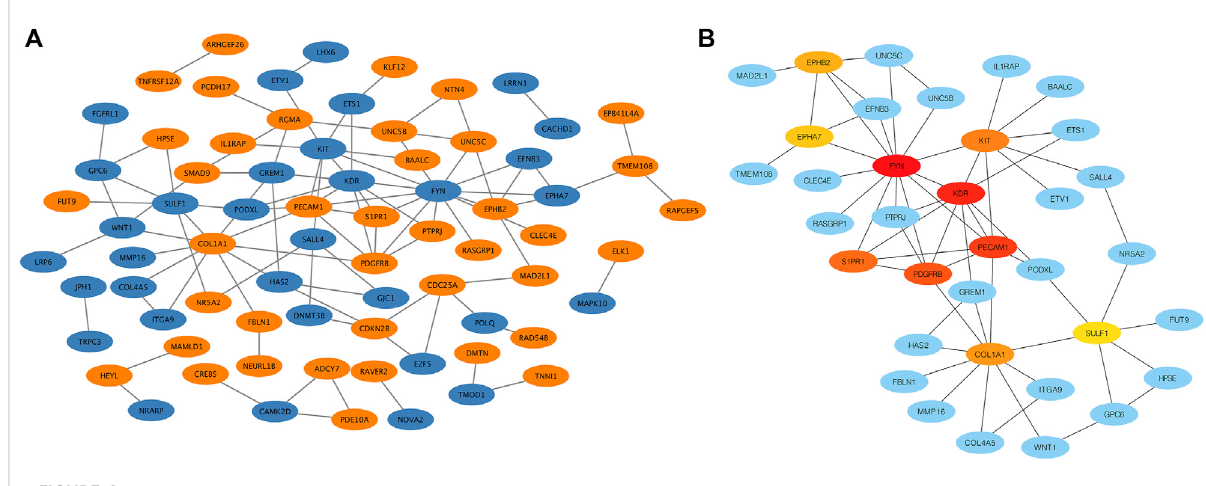
FIGURE 4 Protein – protein interaction (PPI) network. (A) PPI network of overlapping genes. The blue circle represents downregulated overlapping genes, and the orange circle represents upregulated overlapping genes. (B) PPI network of top 10 overlapping genes (hub genes). The darker the circle, the greater the connectivity score.